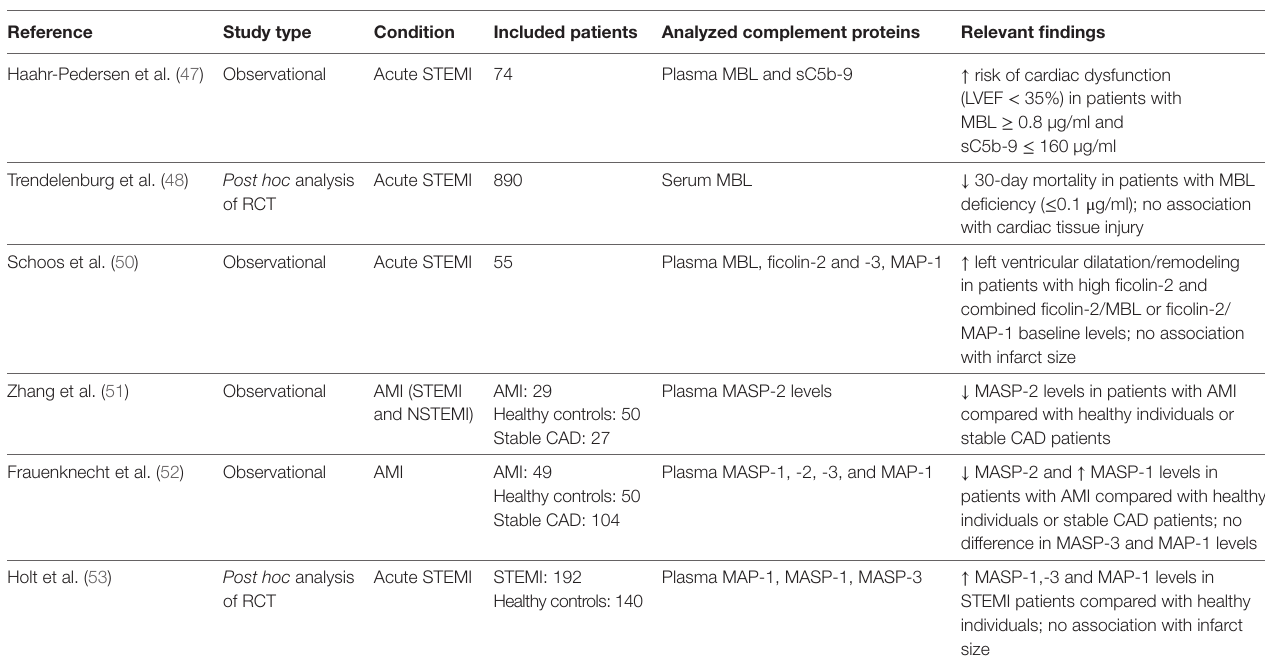
TABLe 2 | Analysis of lectin pathway proteins in patients with